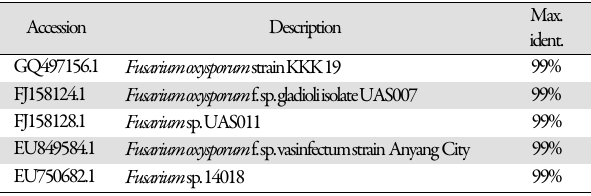
Table 1. List of reference cultures of Fusarium oxysporum in Gen Bank